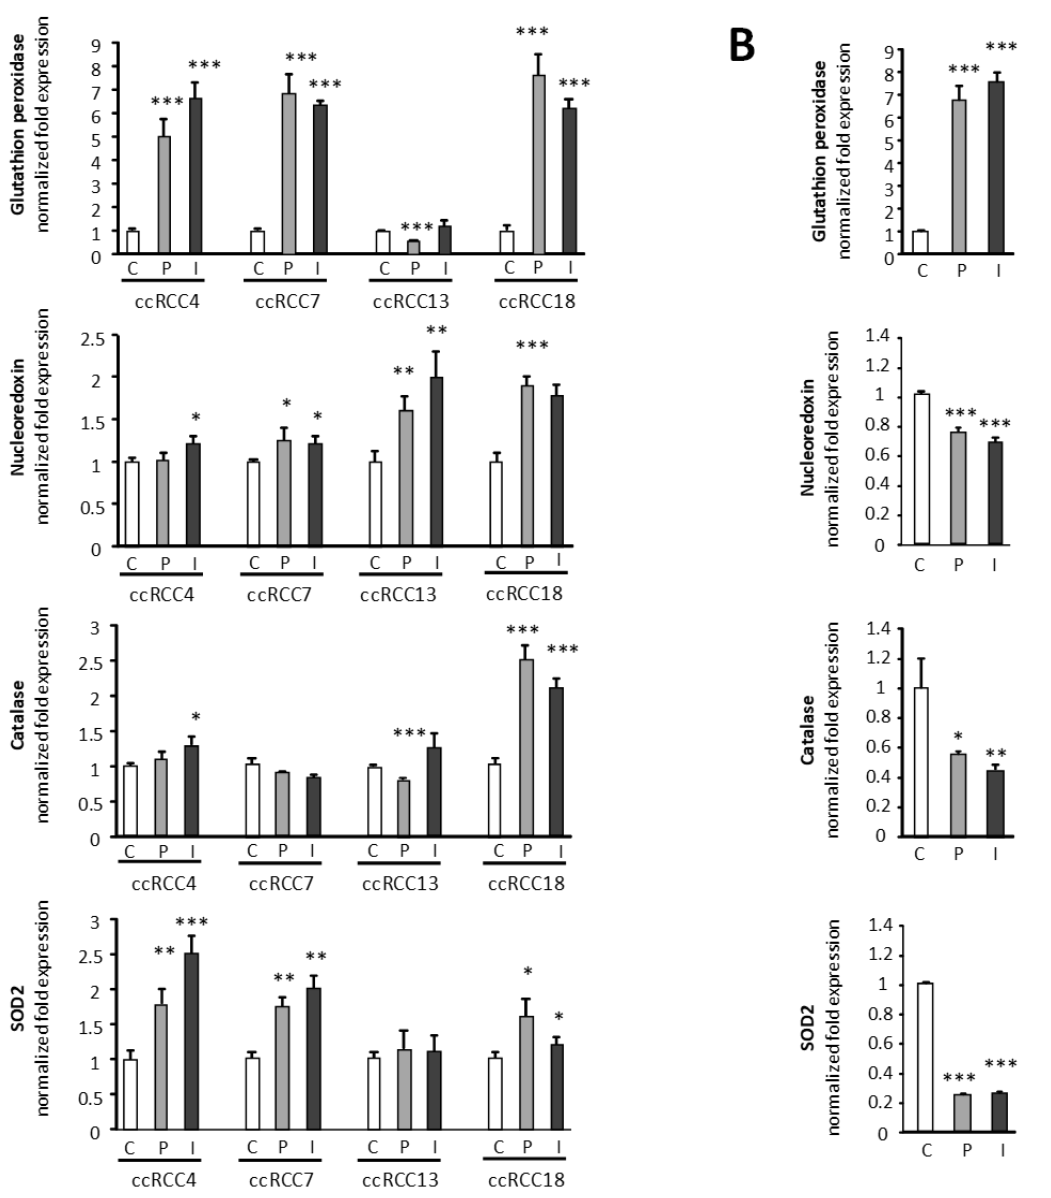
Figure 3. Modulation after treatment with [0 – 50 µM for 786-O and 0 – 100 µM for ccRCC] propranolol or ICI-118,551 of the mRNA expression levels of different ROS processing enzymes: Glutathione peroxidase , Nucleoredoxin , Catalase , and SOD2 analyzed by RT-qPCR: ( A ) On four different VHL-ccRCC primary cultures. ( B ). On the 786-O line. All data are based on 3 independent experiments. Error bars denote ± SEM. Student’s t -test: * p < 0.05; ** p < 0.01; *** p < 0.001. C: Control, P: propranolol and I: ICI-118,551.